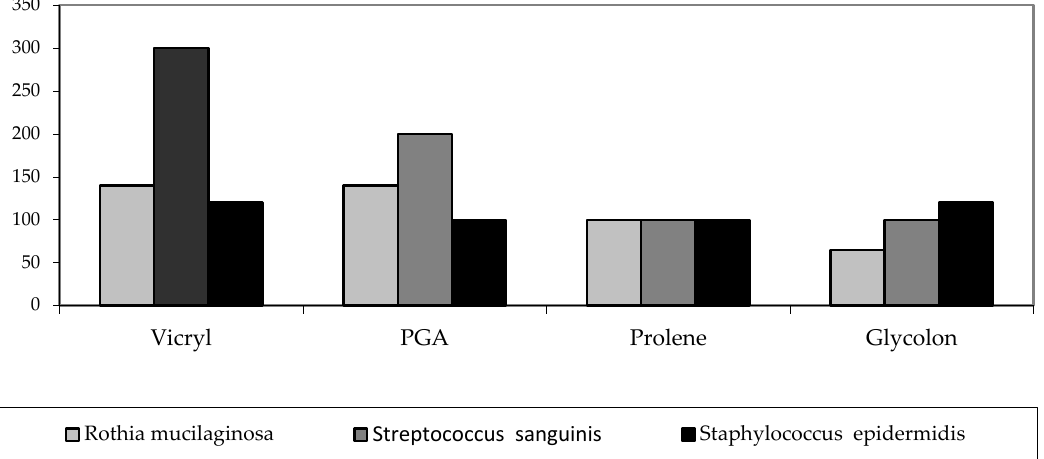
Figure 6. Diagram of the microbes’ volume for each material in the microbiological examination of threads during surgery (median).